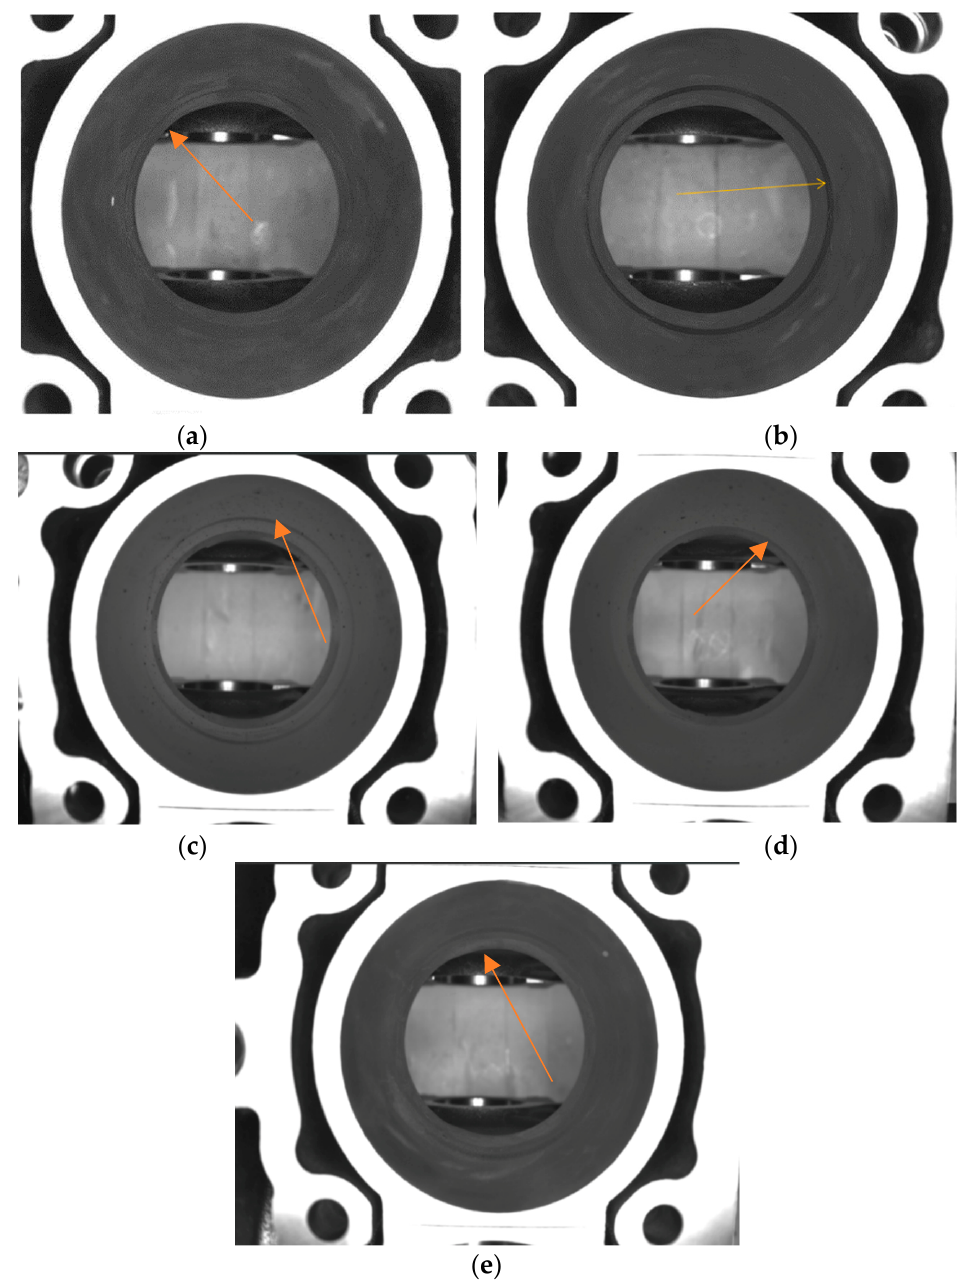
Figure 4. Defects in the cylinder chamber. In ( a – e ) parts with machining defects can be observed. ( a ) presents a barely observable defect and ( b – e ) presents a more prominent one.